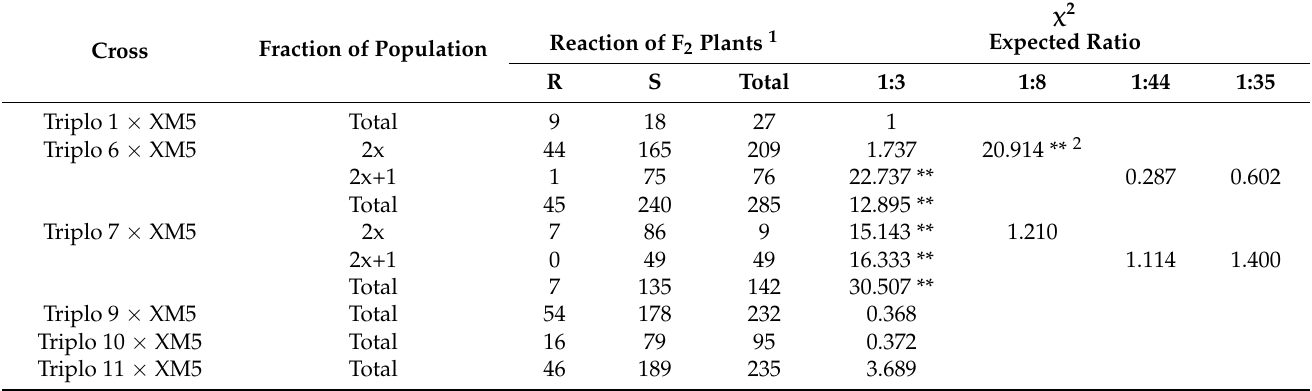
Table 3. Segregation for resistance to the bacterial blight pathogen in F 2 populations from trisomic F 1 plants derived from the cross between trisomics and XM5.